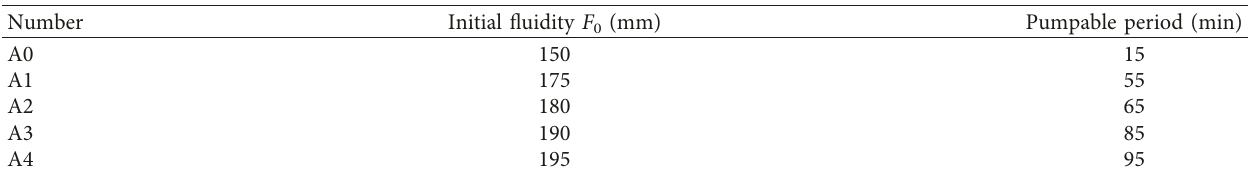
Table 7: Results of slurry fluidity and pumpable period.